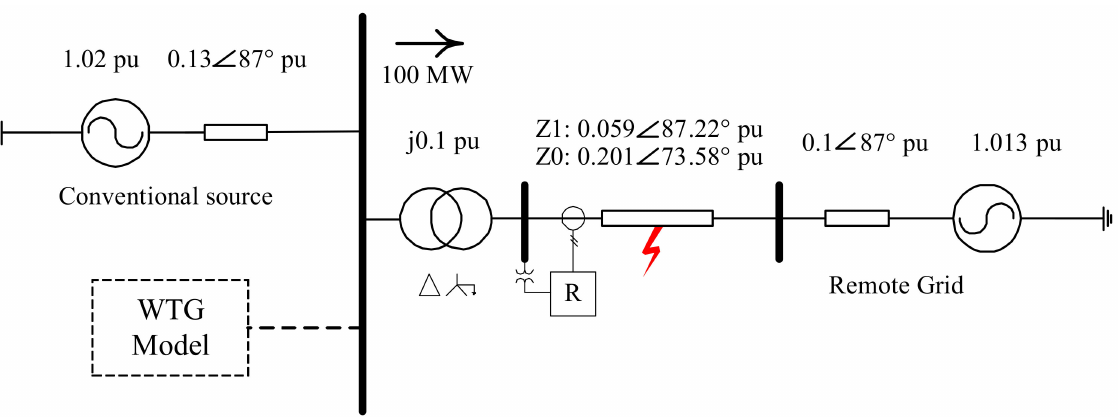
Figure 2. Single line diagram of the power system model used for comparing a conventional source and an